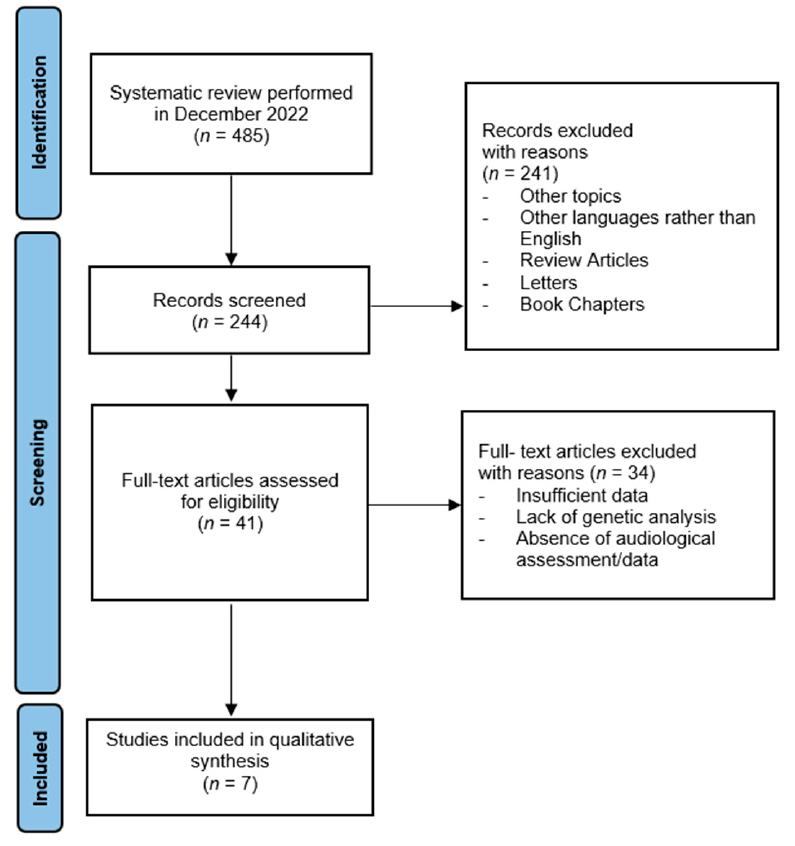
Figure 1. The literature evaluation and selection according to PRISMA criteria [17].